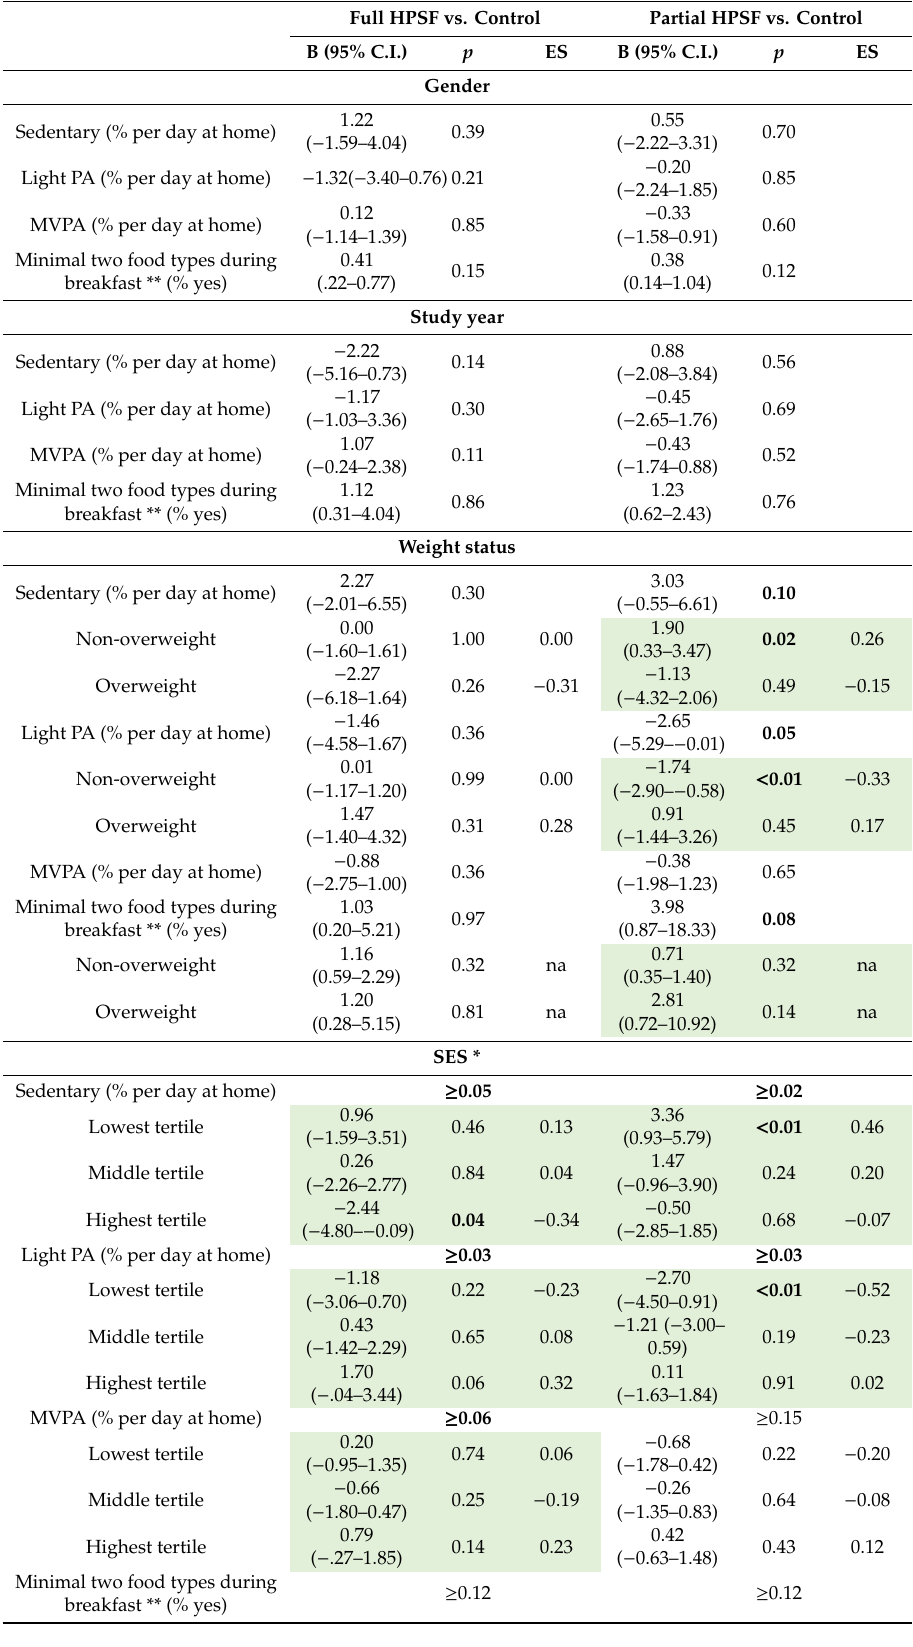
Table 4. E ff ect modifiers of HPSF on intervention e ff ects at home. Full HPSF vs.